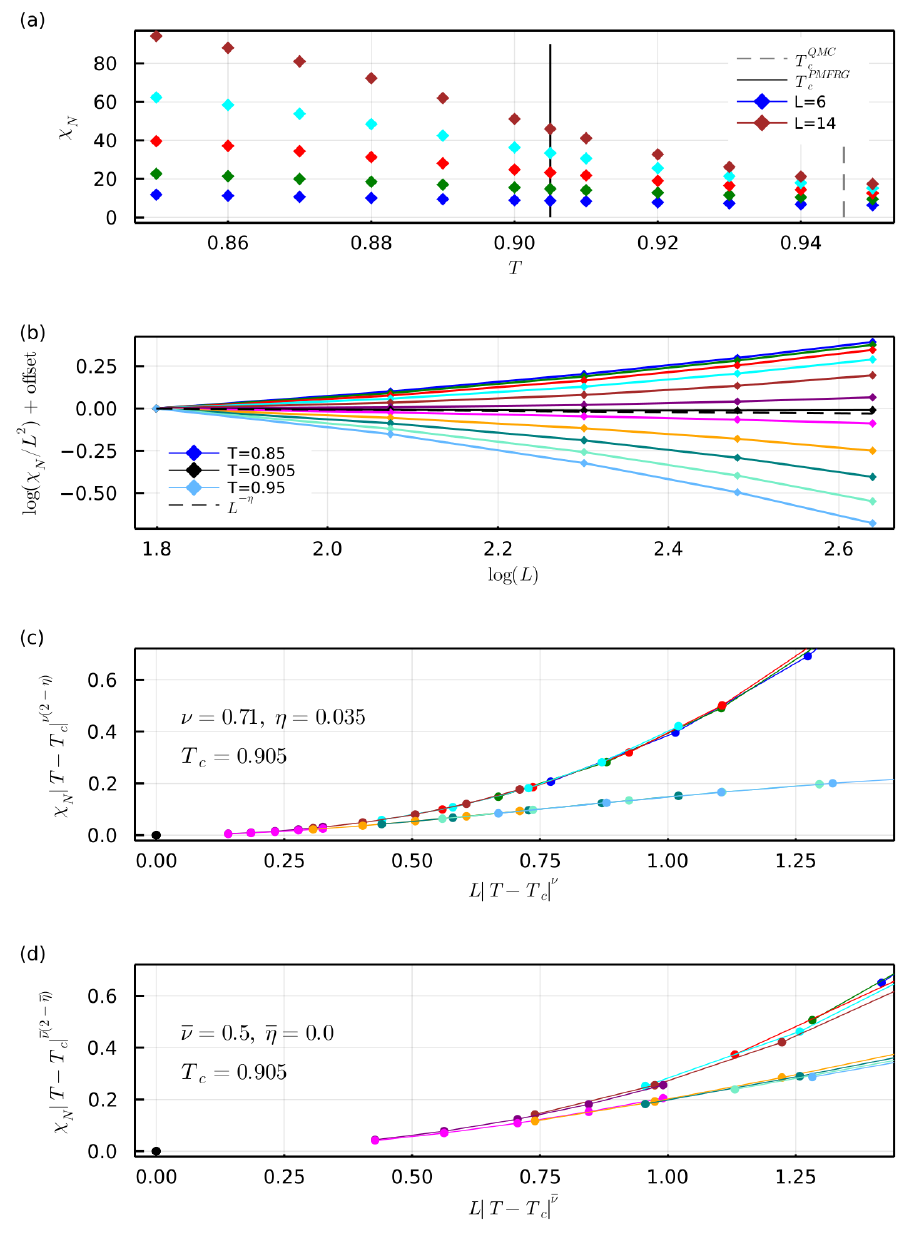
Figure 1: (a) Néel susceptibility from one-loop PMFRG in the antiferromagnetic nearest-neighbor Heisenberg model on the simple cubic lattice for temperatures around T = 0.9 and varying cutoff length L = 6,8,10,12,14. The number of posi- = 32. (b) Length-dependence of the susceptibility tive Matsubara frequencies is N w from (a); the critical temperature can be identified from a pure power-law behav- ior (no curvature in log-log plot). Adjacent curves have a temperature difference of ∆ T = 0.01, except of the black curve which has additionally been inserted for T = 0.905. (c) Scaling collapse for the data using the established critical exponents ν and η from the classical 3D Heisenberg universality class, the same with mean-field exponents is shown in